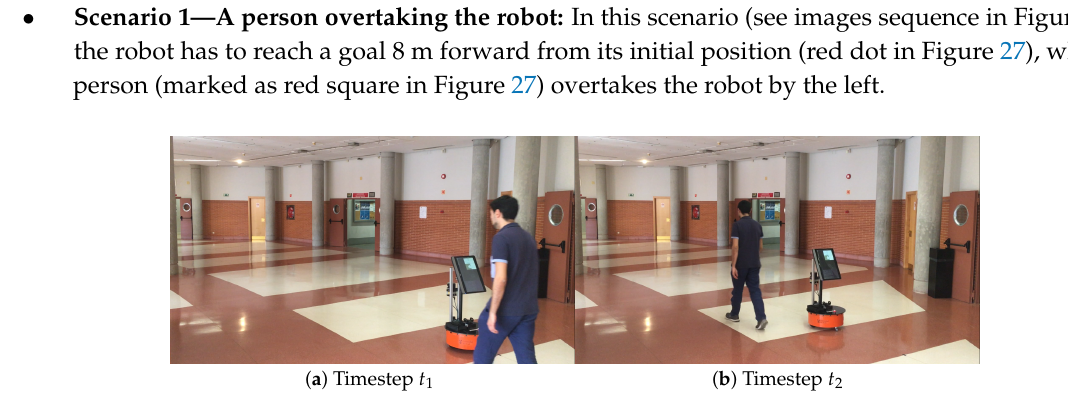
Figure 26. Scenario 1—Images